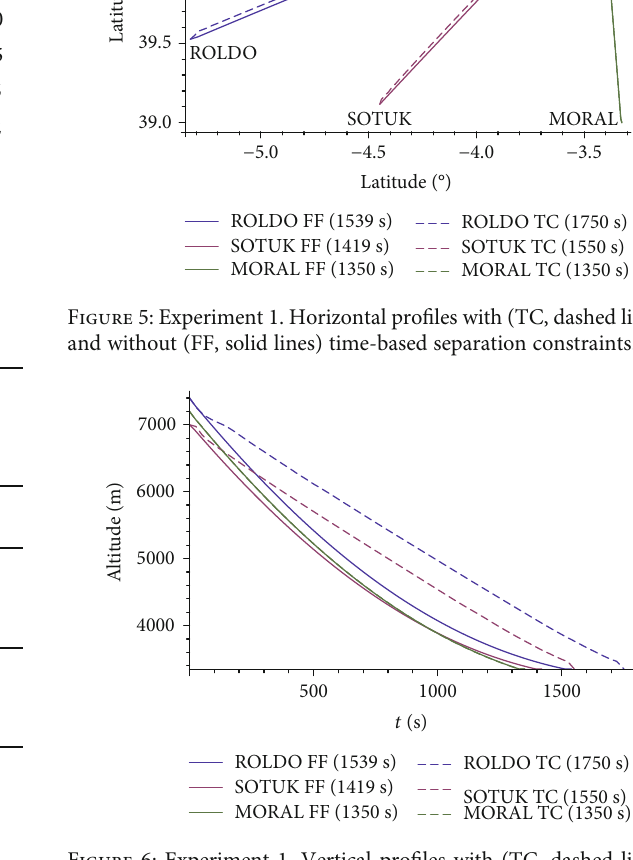
Figure 6: Experiment 1. Vertical pro fi les with (TC, dashed lines) and without (FF, solid lines) time-based separation